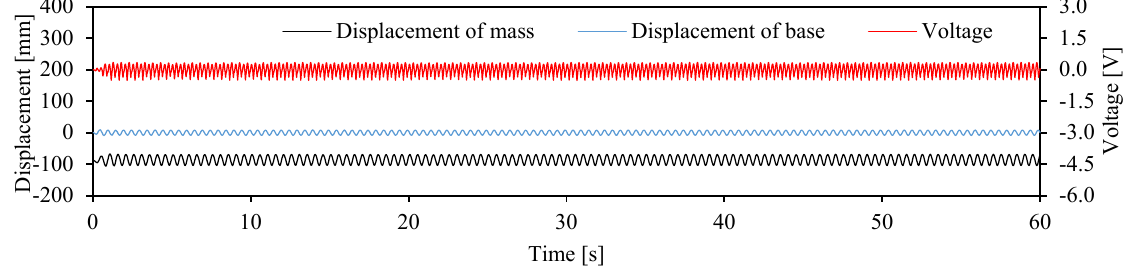
standard deviations of the vibration displacement of the mass block and support point Figure 14. Measurement results for 1.9 Hz periodic signal excitation. Figure 14. Measurement results for 1.9 Hz periodic signal excitation. were 7.34 and 5.33 mm, respectively, which resulted in 0.80 mW of power generated.